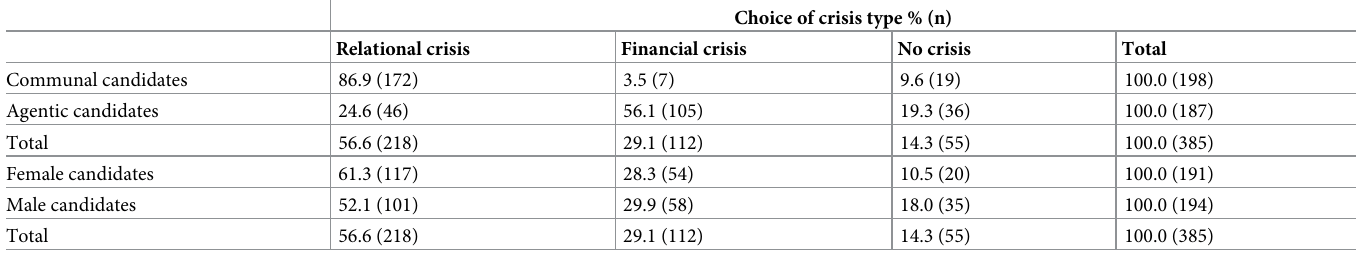
Table 3. Choice of a relational crisis versus financial crisis versus no crisis as a function of candidate gendered traits and candidate gender (Study 3, United States of